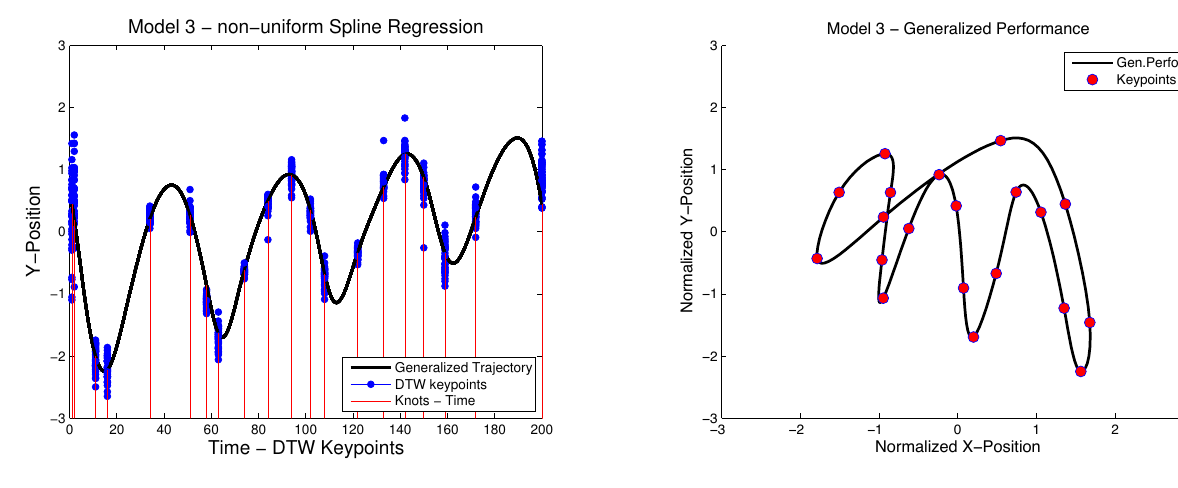
Figure 9. Generalized trajectory and its key points for conducting model